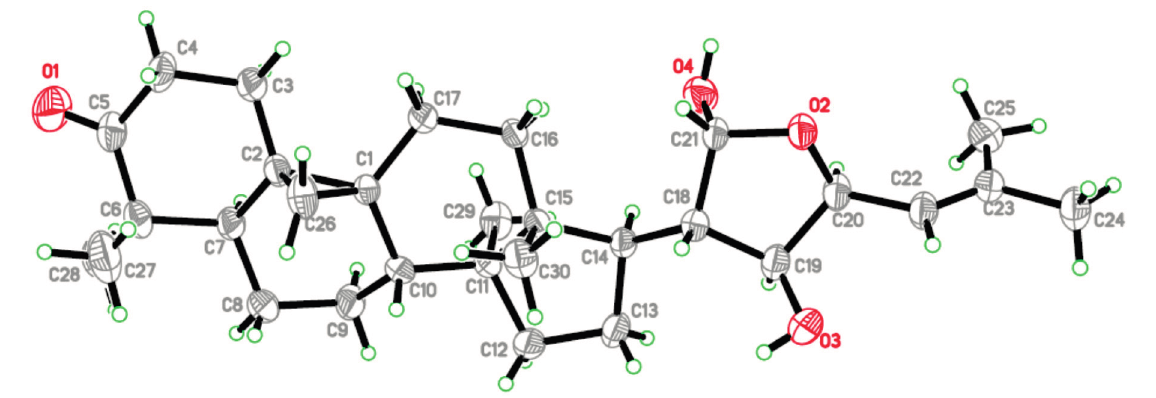
Figure 2. Selected HMBC and 1 H- 1 H-COSY correlations for 1 .